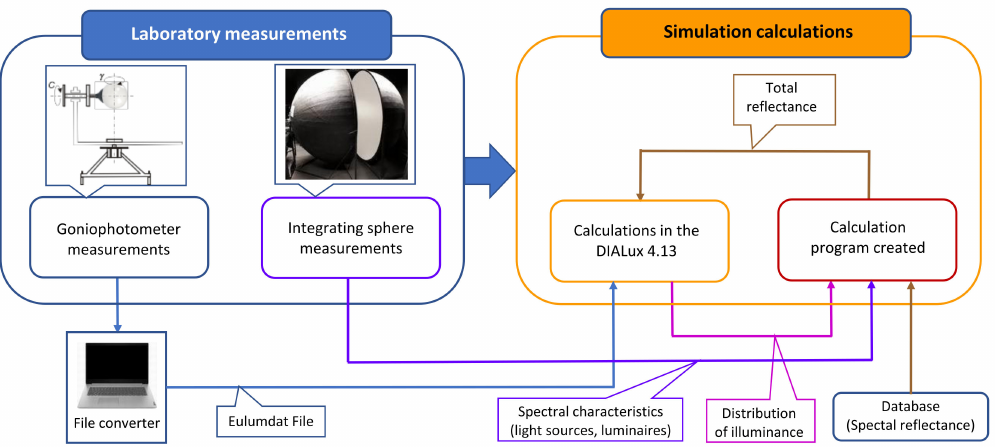
Figure 2. Schematic representation of the research